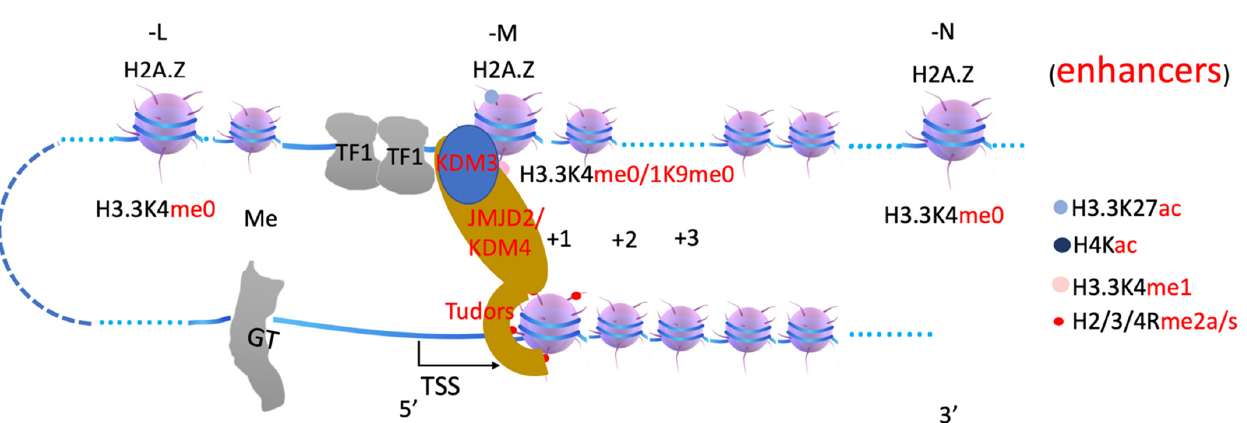
Figure 5. A model of transcription of how KDM3/4 is recruited by arginine methylated histone on +1 nucleosome. KDM3/4 are H3K9 and H3K36 specific lysine demethylases to remove methyl groups on H3.3K9 at enhancer regions. Tudor domain is specific to recognize arginine methylated histone tails at +1 nucleosome.